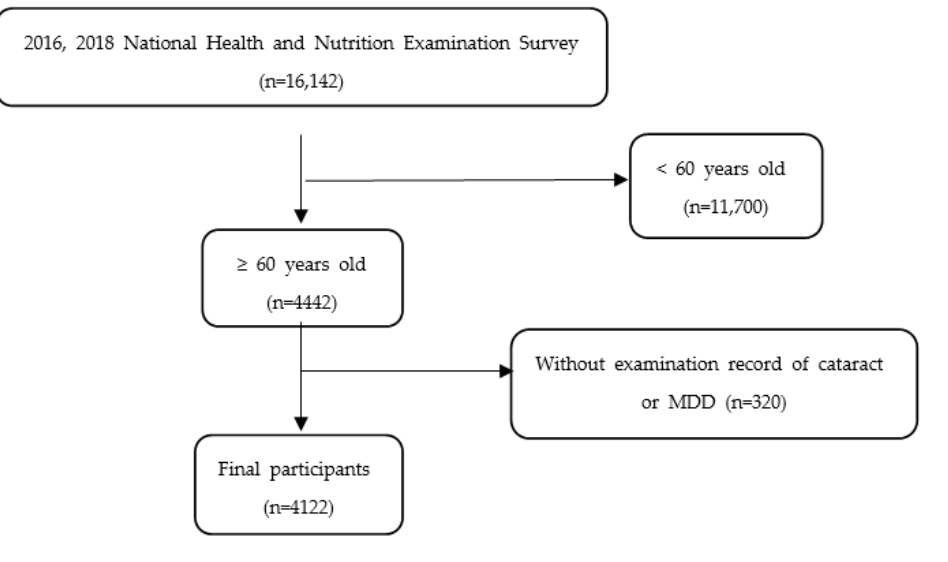
Figure 1. Flow chart of final participants.